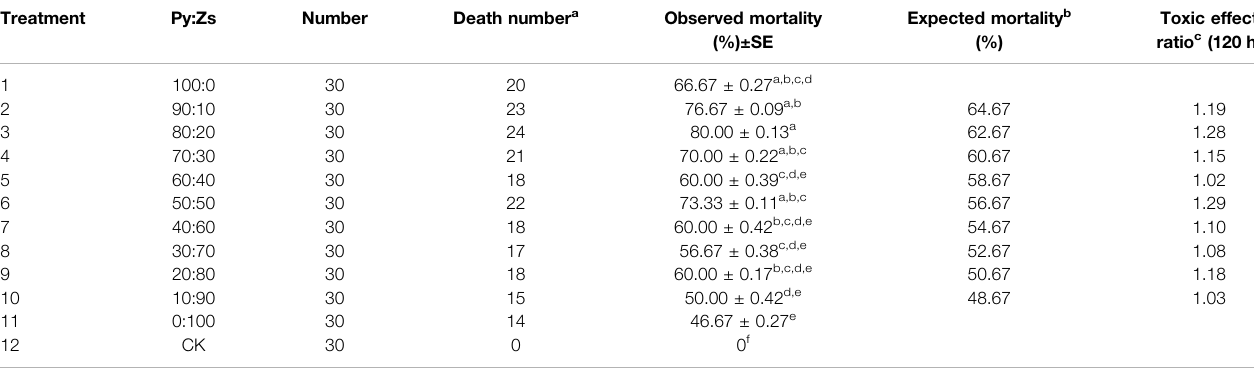
TABLE 3 | Interactions between pymetrozine and zhongshengmycin against third instar nymphs of Nilaparvata lugens 5 days after treatment.